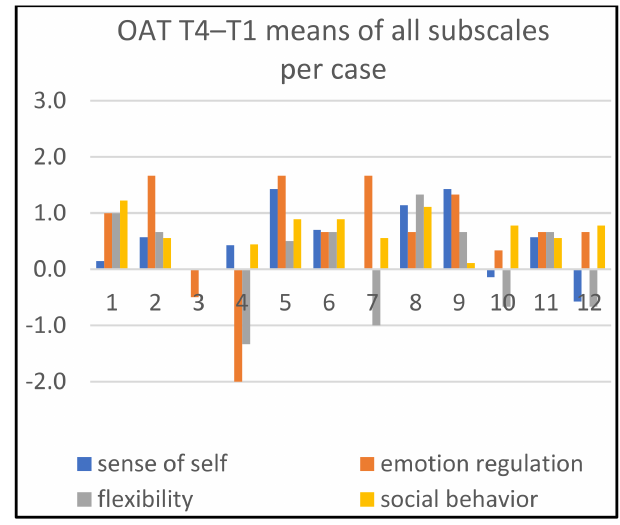
Figure 6. Means of all subscales per case,